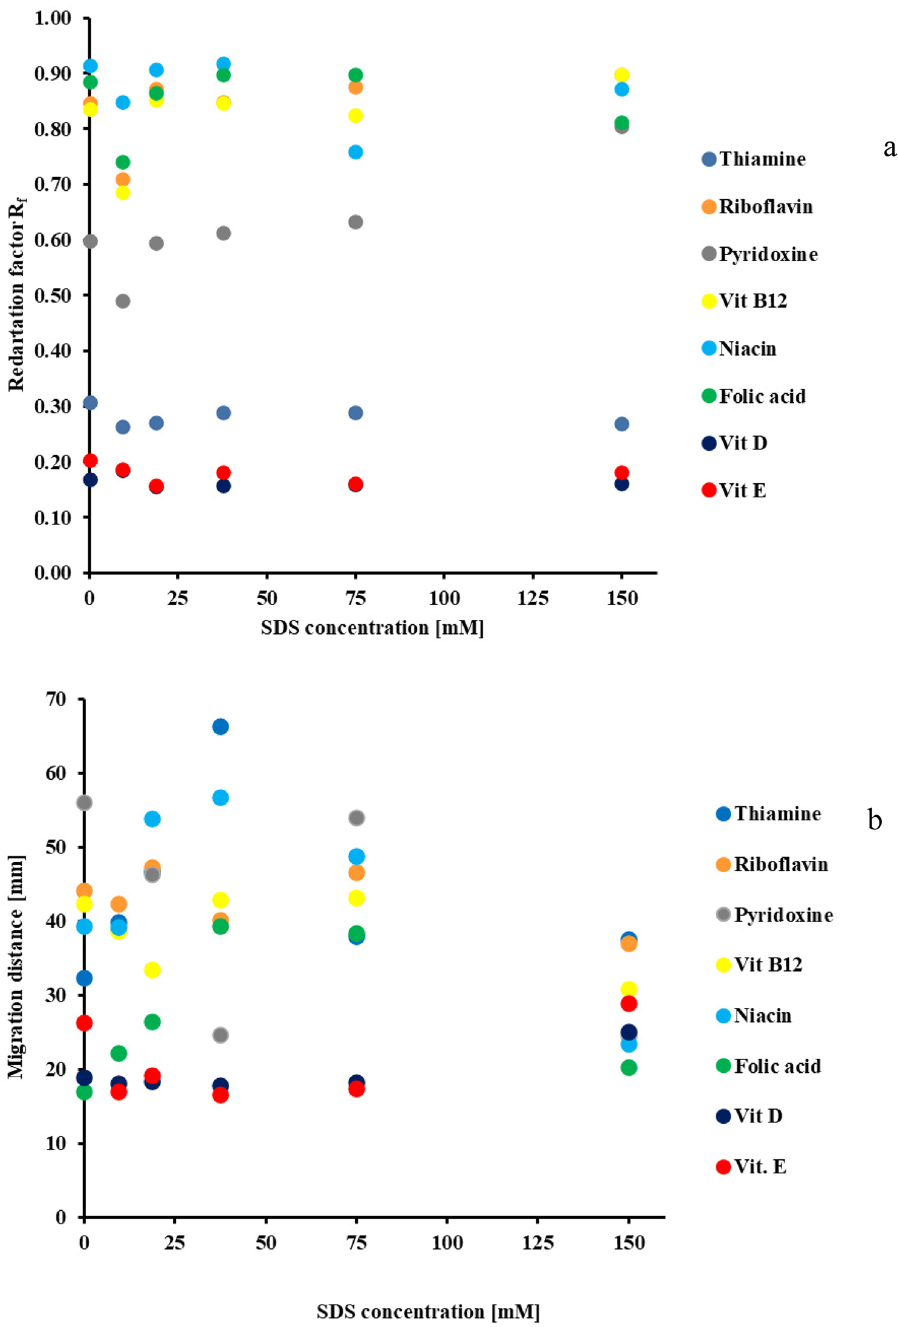
Figure 1. The effect of SDS concentration on investigated vitamins: ( a )—retention (in TLC) and ( b )— migration distance (in PPEC). The mobile phase composition was acetonitrile 50% v / v and aqueous buffer (pH 6.99—composed of acetic acid, phosphoric acid, and boric acid (2.74 mM each), as well as sodium hydroxide (8.60 mM)). For TLC, the distant migration of the eluent front was 45 mm at an ambient temperature of 25 °C. For the PPEC experiment, the time 8 was min., polarisation voltage was 800 V, the temperature was 23